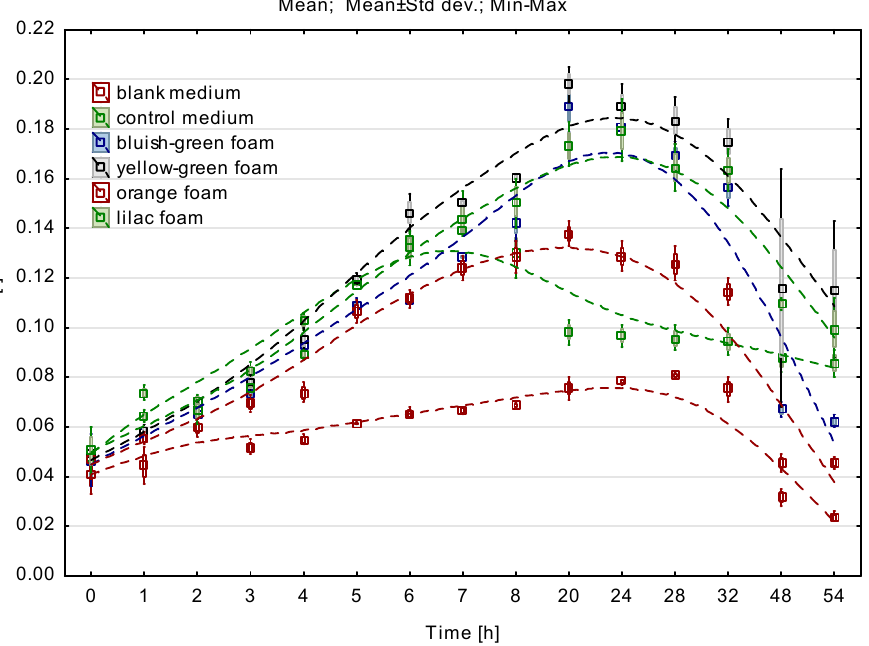
Figure 2. Optical density for batch culture using open-pore flexible PUFs (microbial culture growth kinetic curves).